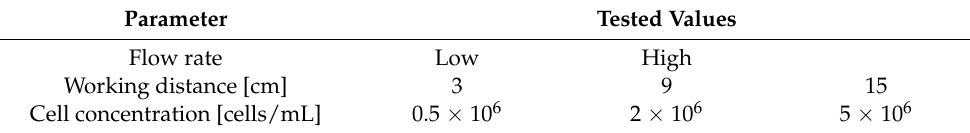
Table 2. Overview of investigated spray parameters for the evaluation of cell viability. Parameter Tested Values Flow rate Low High Working distance